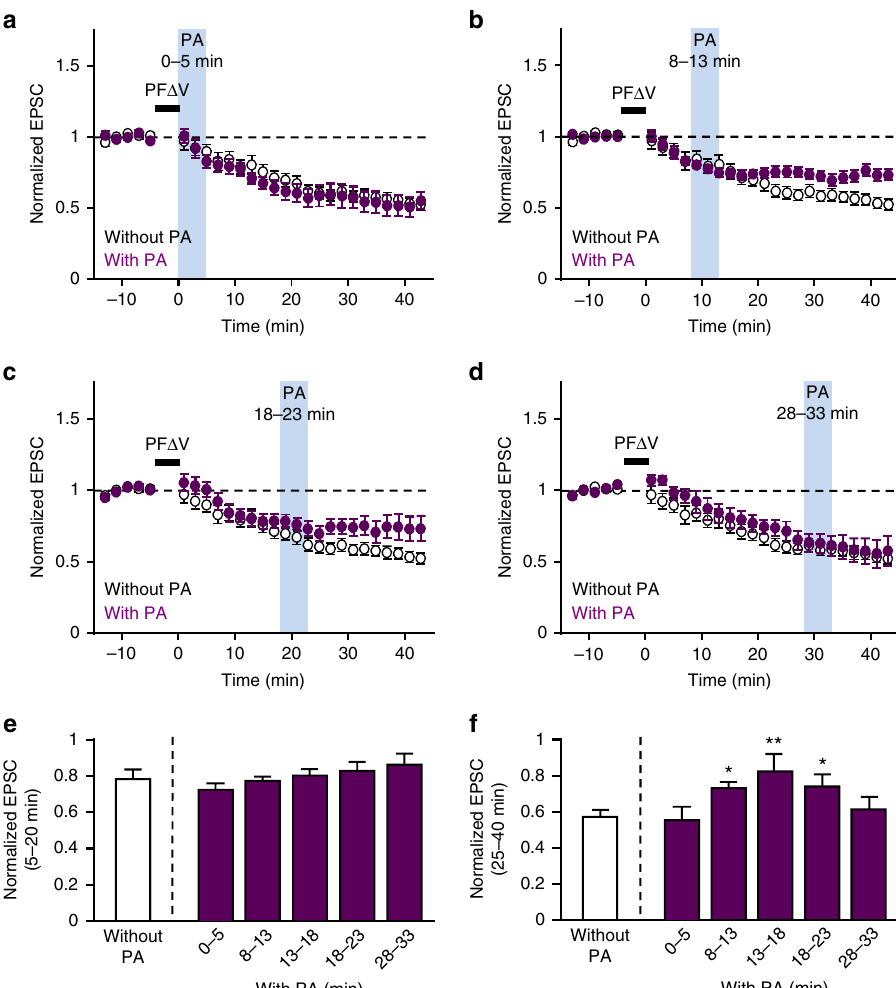
Fig. 6 Restricted time window of the requirement of LE sorting for LTD. a – d Effect of photoactivation of PS-Rab7TN at various times ( light blue columns ) after PF Δ V on LTD ( purple circles ; 0 – 5 min, n = 9; 8 – 13 min, n = 20; 18 – 23 min, n = 11; 28 – 33 min, n = 8). Control LTD without photoactivation shown in Fig. 5b is overlaid for comparison in each panel ( open circles ). e , f Average amplitudes of normalized PF-EPSCs calculated at 5 – 20 min e or 25 – 40 min f after the end of PF Δ V with photoactivation at various times. * P < 0.05, ** P < 0.01, two-way ANOVA followed by the Fisher ’ s LSD test. Exact P values for the data sets in this fi gure are provided in Supplementary Table photoactivation (Fig. 7b, red symbols , PF-EPSC amplitudes after photoactivation > 0.8). In contrast, another group was unaffected by PS-Rab7TN photoactivation and eventually showed LTD (Fig. 7b, blue symbols , PF-EPSC amplitudes after the photo- activation < 0.8) similar to normal. Two-way analysis of variance (ANOVA) con fi rmed that the former group was signi fi cantly different from the latter group and from the case without photoactivation (Supplementary Fig. 8a). On the other hand, the latter group was not distinguishable from that without photo- activation (Supplementary Fig. 8a). In addition, comparison within individual periods con fi rmed that the signi fi cant differ- ences arise from PF-EPSC amplitudes after the photoactivation (Supplementary Fig. 8b). Thus, we de fi ned the former and latter groups as recovery and LTD groups, respectively. The averaged time course of LTD in each group clearly demonstrated the two distinct responses: in the recovery group, LTD was interrupted upon photoactivation and PF-EPSCs returned to their basal amplitude, whereas LTD was stably maintained in the LTD group (Fig. 7c). In the recovery group, normalized amplitudes of PF-EPSCs calculated at 35 – 45 min after PF Δ V were ~1 and signi fi cantly larger than those without photoactivation or those in